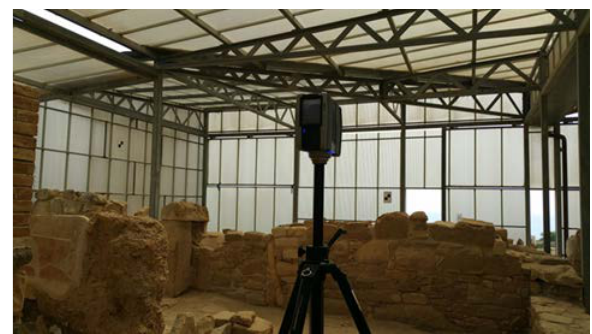
Figure 10. Laser scanning survey.